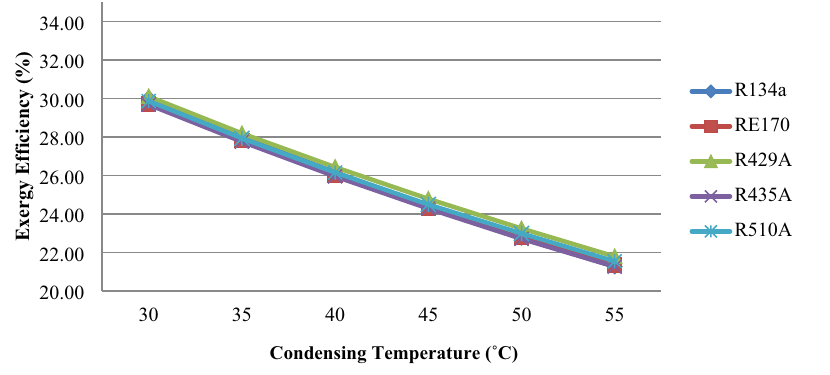
Figure 4. Exergy Efficiency and Condensing Temperature.